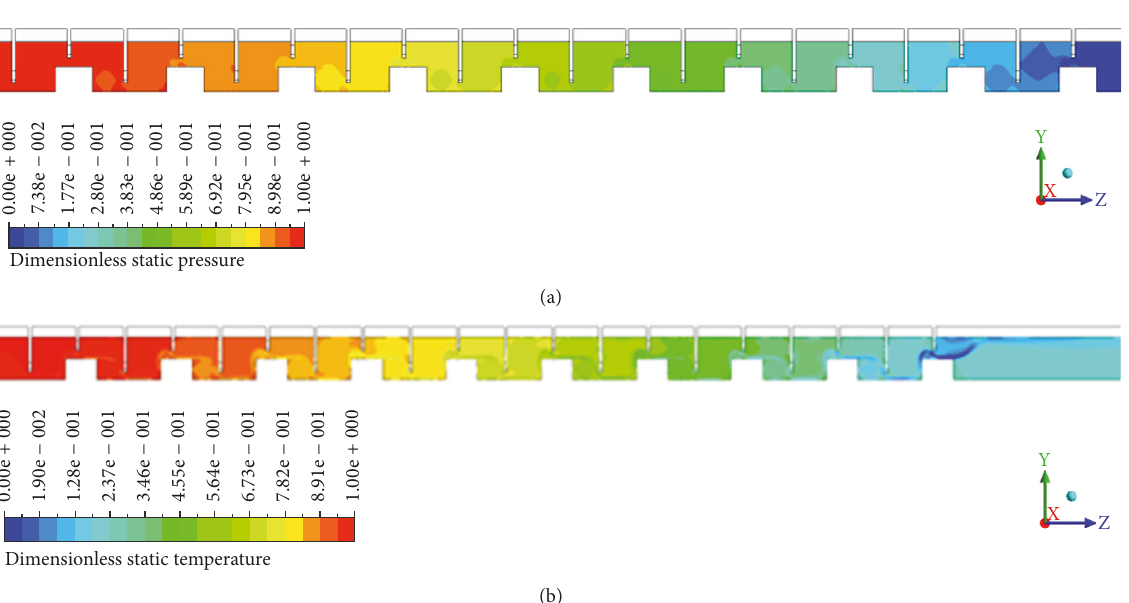
Figure 10: Nondimensional static pressure (a) and temperature (b) contours.